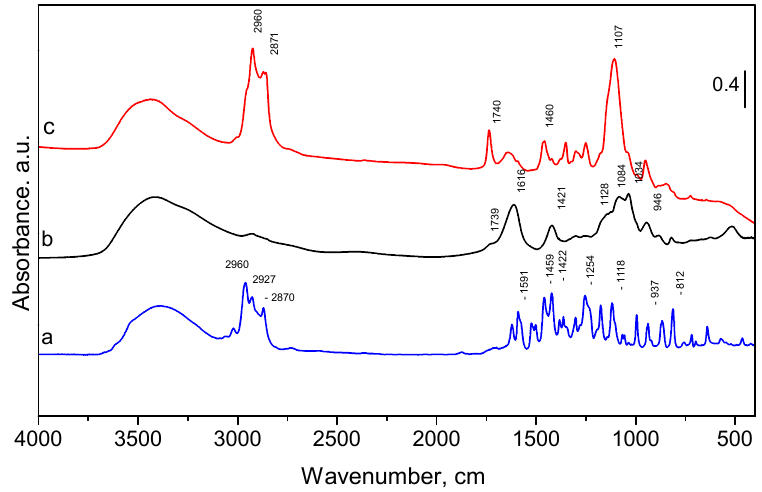
Figure 2. FTIR spectra of pure oregano oil ( a ), empty ( b ) and OrO-loaded chitosan-alginate nanoparticles ( c ).